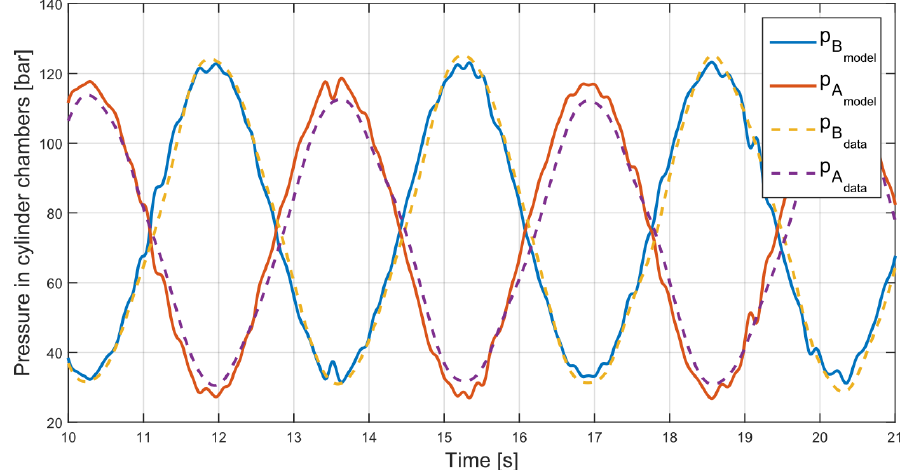
Figure 15. Piston force from the experiments and the mathematical model for the constant-pressure